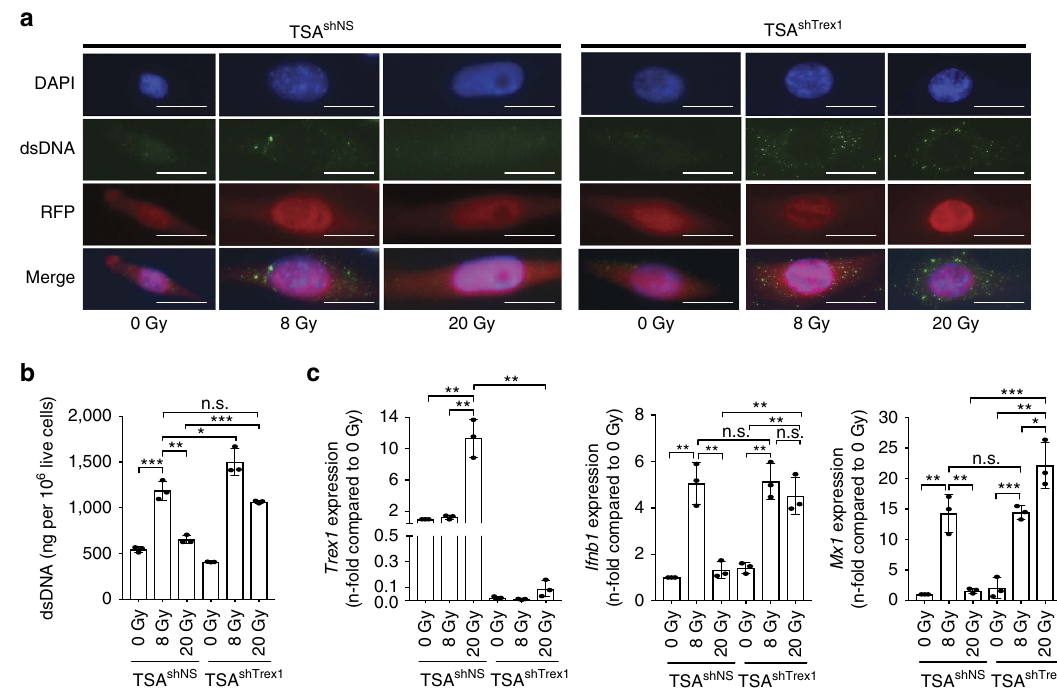
Figure 4 | Trex1 knockdown restores cytosolic dsDNA accumulation and induction of ISGs in TSA cells treated with 20 Gy. ( a–c ) TSA shNS and TSA shTrex1 cells were treated with doxycycline to induce Trex1 knockdown and tRFP expression, then exposed to a radiation dose of 8 Gy or 20 Gy. ( a ) After 24h cells were fixed, permeabilized and stained with an antibody specific for dsDNA, followed by detection with Alexa fluor 488-conjugated secondary antibody. Representative micrographs show DAPI-stained nuclei (blue), cytoplasmic dsDNA (green), cytoplasmic tRFP (red), and the three channels combined. Magnification: (cid:3) 400; duplicate; n ¼ 3 per group. White bars, 10 m m. ( b , c ) After 24h cells were harvested for measurement of cytoplasmic dsDNA ( b ) or Trex1 , Ifnb1 and Mx1 expression by qRT-PCR ( c ). Duplicate; * P o 0.05; ** P o 0.005; *** P o 0.0005: t -test; n ¼ 3. All data are mean ±